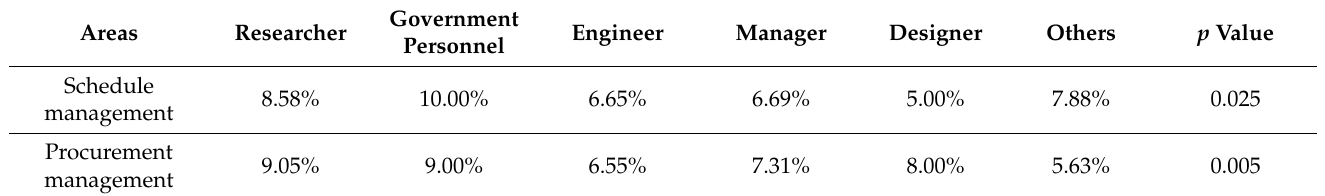
Table 8. The mean score of perceived improvement from respondents with different designations.